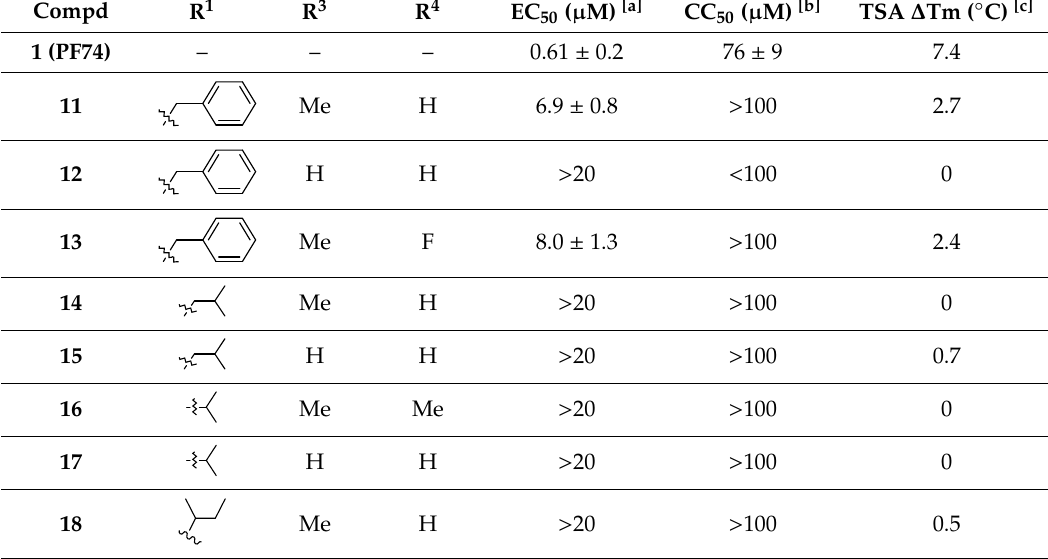
Table 2. Anti-HIV-1 activity, cytotoxicity, and CA hexamer stability profiles of 11–21 (R 1 , R 3 , and R 4 ). Compd